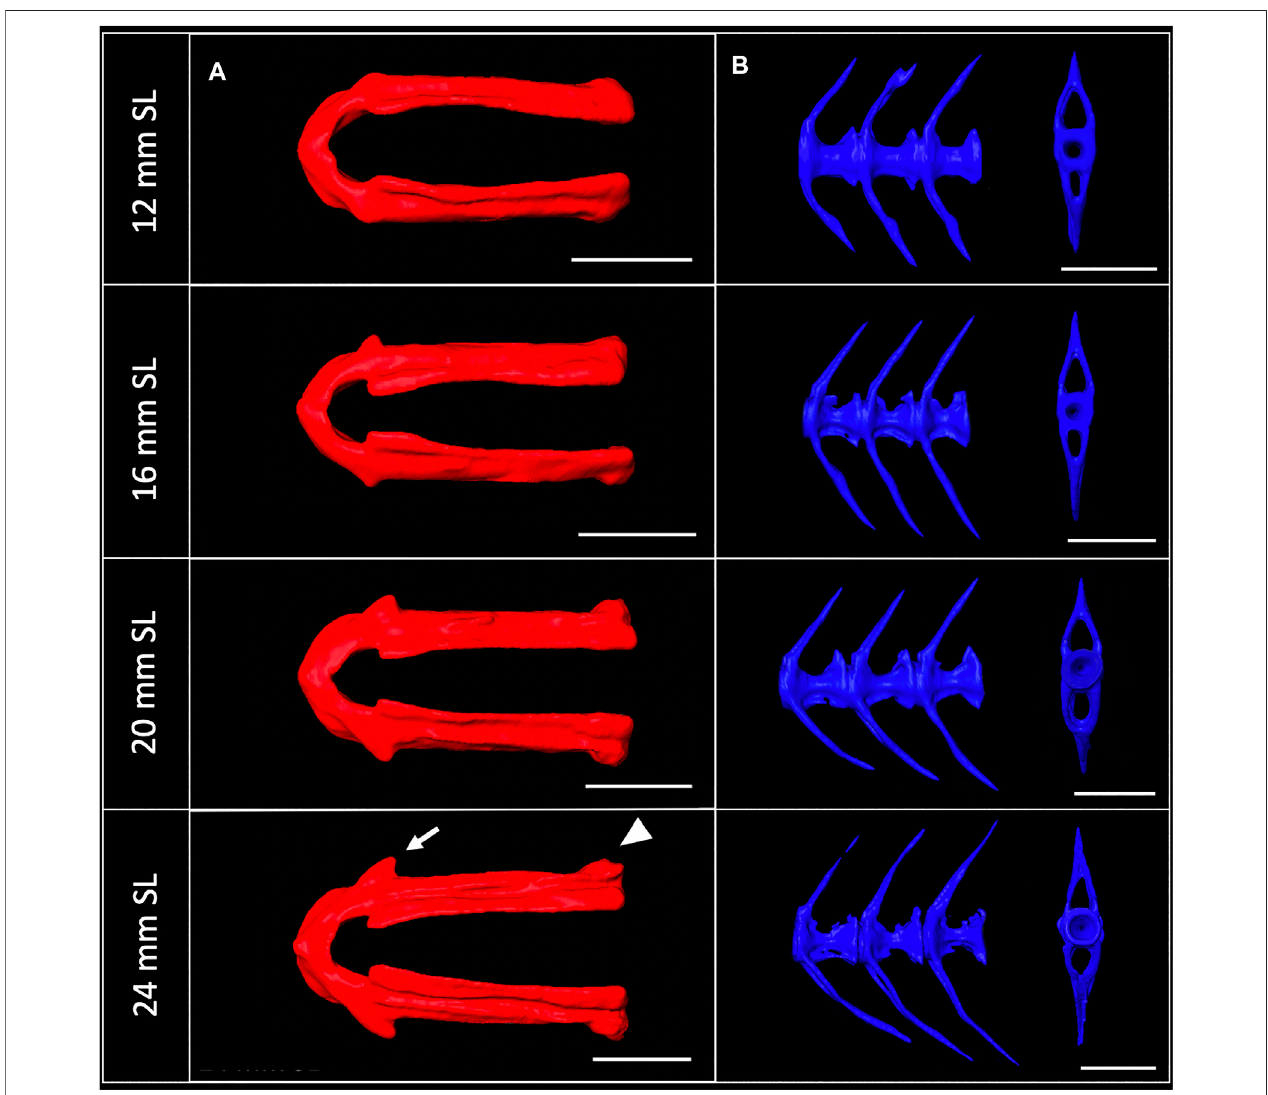
FIGURE 5 | Shape change of the lower jaw and caudal vertebrae. (A) , Segmented lower jaws from 12, 16, 20, and 24 mm SL individuals, viewed from the ventral perspective. In the largest individuals, note the pronounced anguloarticular prominence (arrow) and posterior end of lower jaw (arrowhead). (B) , Segmented fi rst three caudal vertebrae from 12, 16, 20 and 24 mm SL individuals, viewed from a lateral perspective. Scale bars, 0.5 mm.